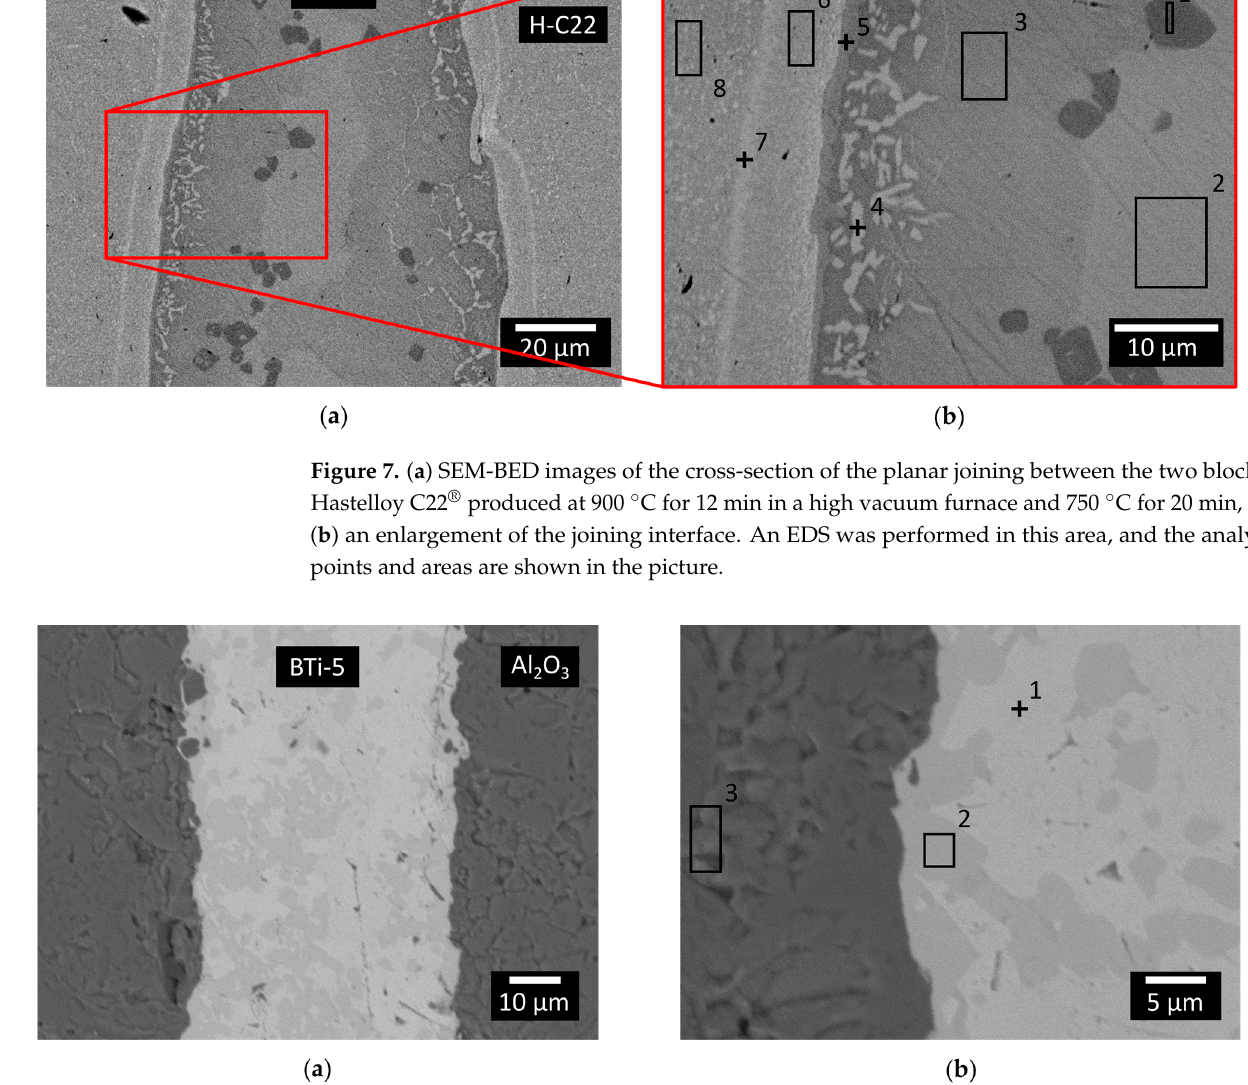
Figure 8. ( a ) SEM-BED images of a cross-sectioned planar joint between the two blocks of Al 2 O 3 produced at 900 °C for 12 min in a high vacuum furnace and 750 °C for 20 min and ( b ) its related zoomed area. An EDS was performed in this area and the analyzed points and areas are shown in the picture. Table 5. Composition (at %) measured by means of EDS analysis of the points and areas indicated in Figure 8b.